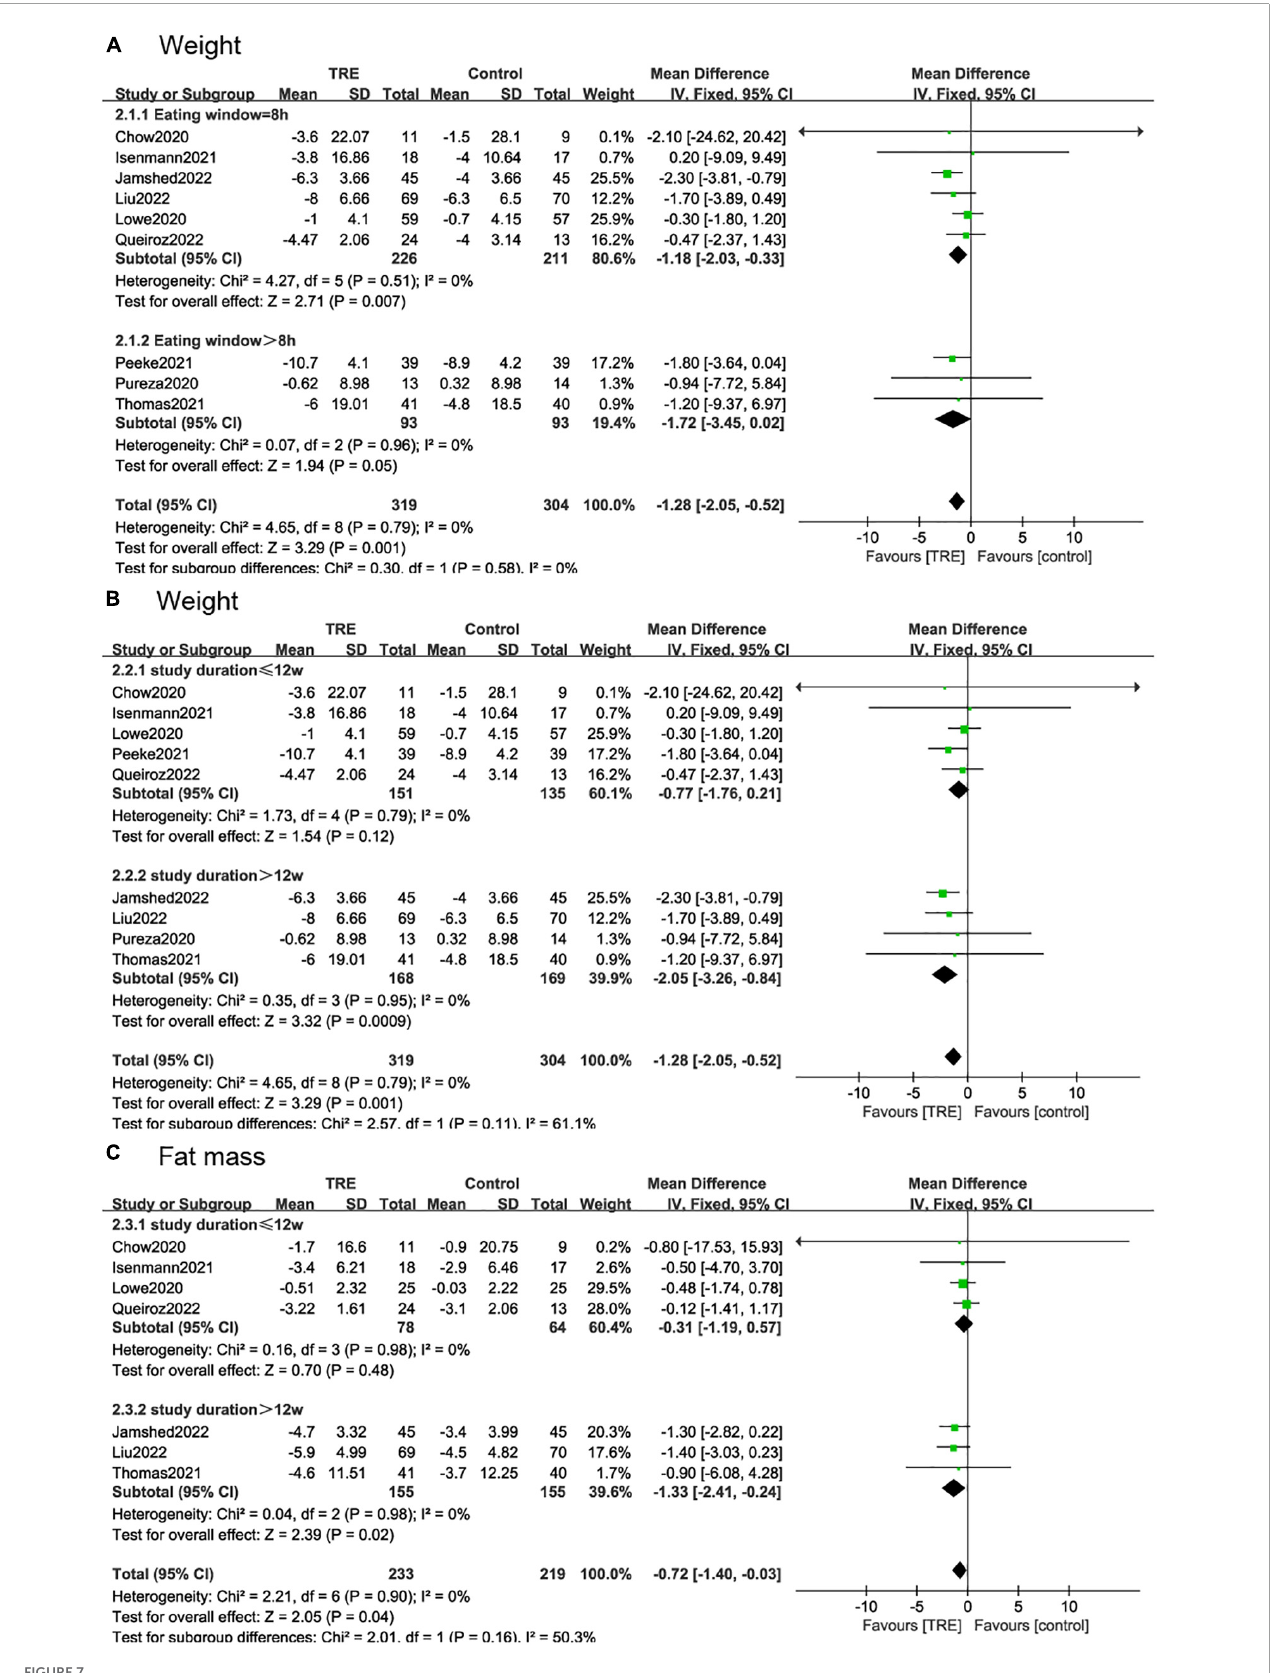
FIGURE7 Forest plot of (A) weight change under the eating window in subgroups of 8 h (2.1.1) and over-8 h (2.1.2); (B) weight change under the study durations in subgroups of ≤ 12 weeks (2.2.1) and > 12 weeks (2.2.2); and (C) fat mass change under the study durations in subgroups of ≤ 12 weeks (2.3.1) and > 12 weeks